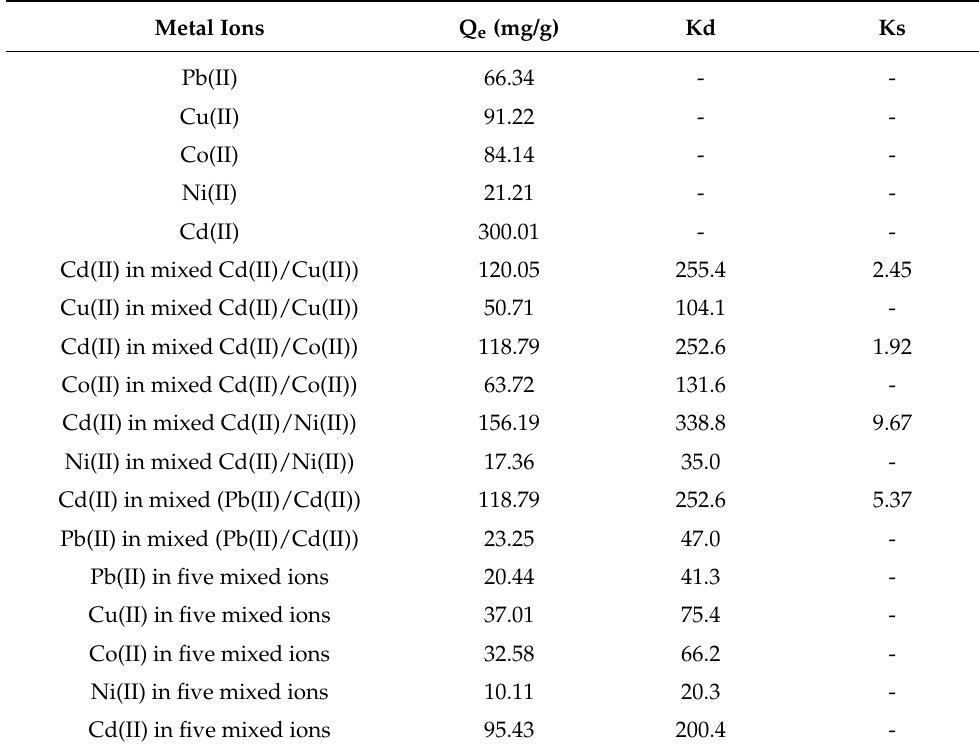
Table 5. Selective adsorption by the XMPC from a solution of mixed